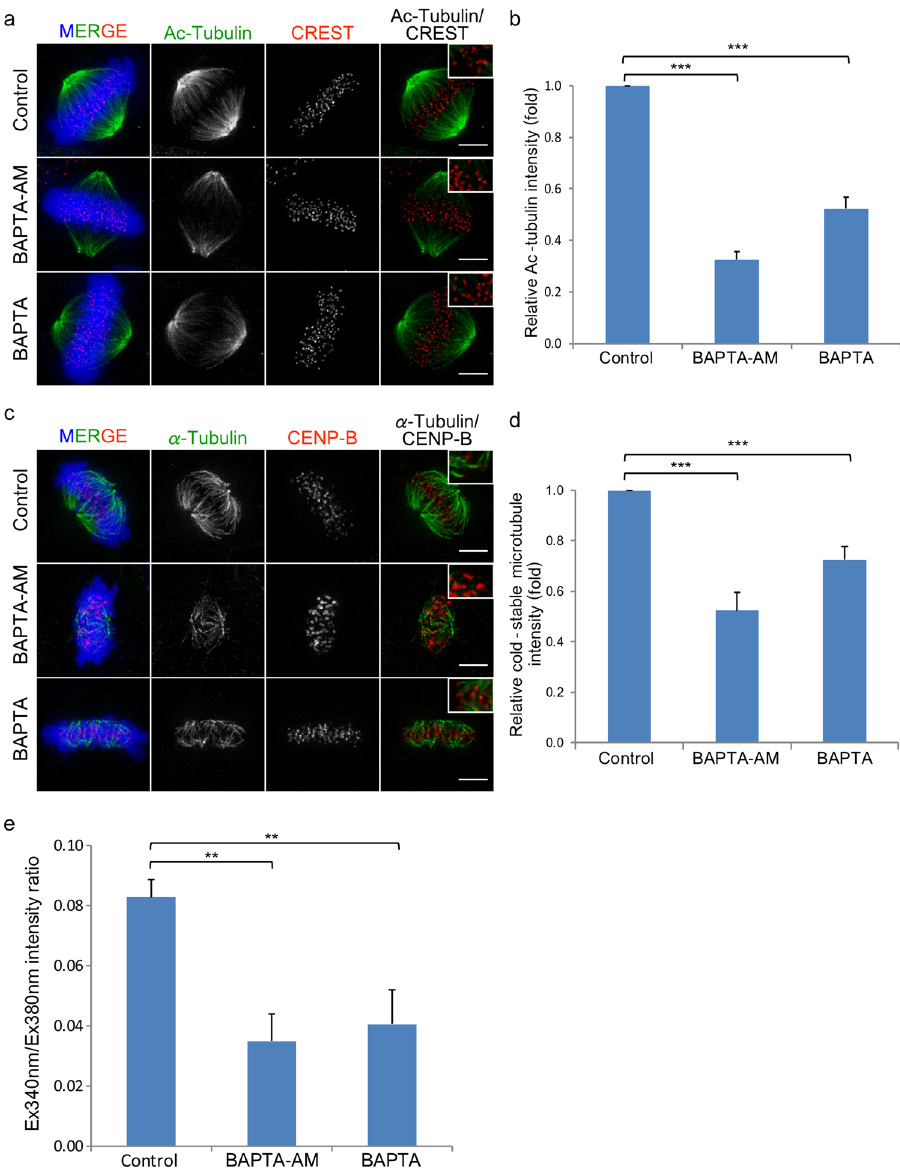
Figure 1. Ca 2 + -depletion reduces the stability of spindle fibres. ( a ) HeLa WT cells arrested at metaphase using MG132 were treated with 25 µ M BAPTA-AM or 10 mM BAPTA and 5 µ M ionomycin to reduce intracellular Ca 2 + then stained with anti-Ac-tubulin antibody. ( b ) A graph presenting the relative Ac-tubulin intensity at kinetochore of each treatment. ( c ) Fluorescence images of metaphase cells in control, BAPTA-AM and BAPTA (with ionomycin) treatments after exposure to low temperature. ( d ) A graph presenting the relative cold-stable microtubule intensity at kinetochore of each treatment. ( e ) A bar graph showing the intensity ratio of Fura-2 excited at 340 and 380 nm measured in mitotic cells, which represent intracellular calcium levels. Error bars indicate standard deviations derived from three independent experiments. Bar, 5 µ